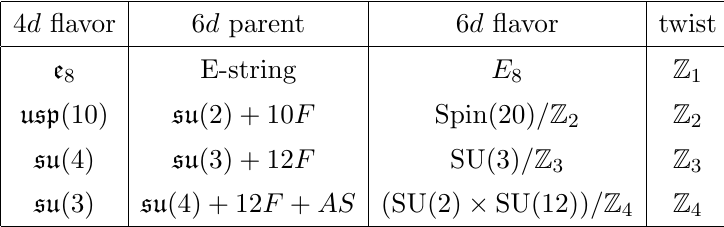
Table 2 . 6 d realizations of 4 d N = 2 rank-1 theories listed in table 1. Here, g + nF means a g gauge theory with n hypermultiplets in the fundamental representation; + AS means that there is also a hypermultiplet in the second rank antisymmetric